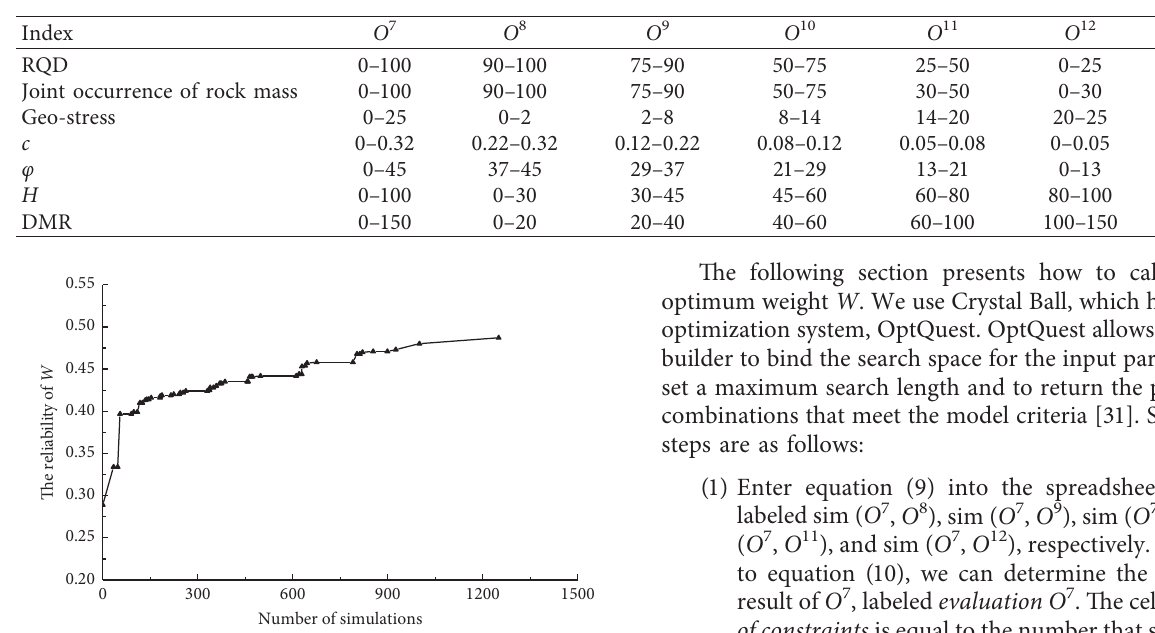
Figure 4: The coupled TOPSIS and MCS model for calculating W implemented in an Excel spreadsheet. Table 2: Data of the simulation model.